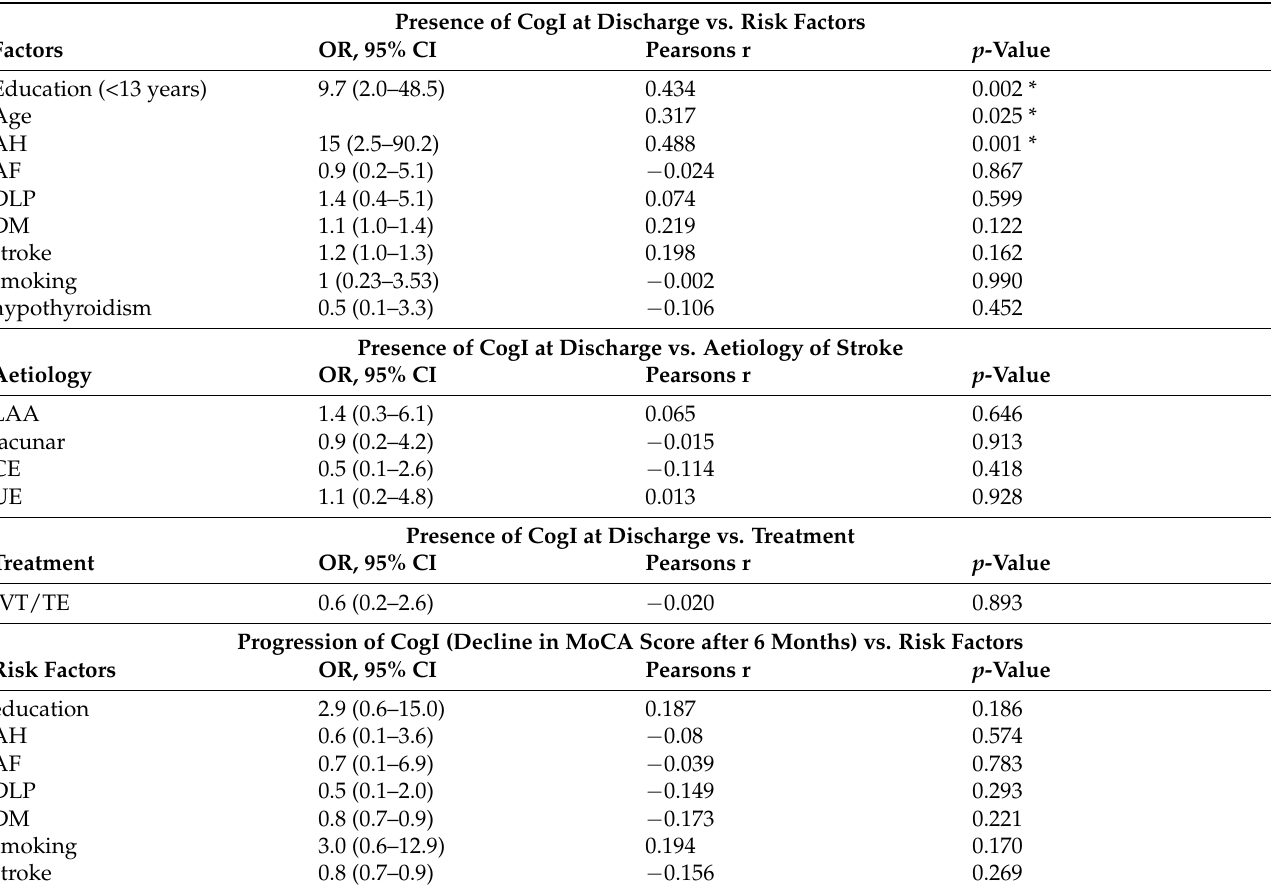
Table 3. Summary of correlation analysis between presence of CogI at discharge and selected variables (risk factors, type of the treatment, and stroke